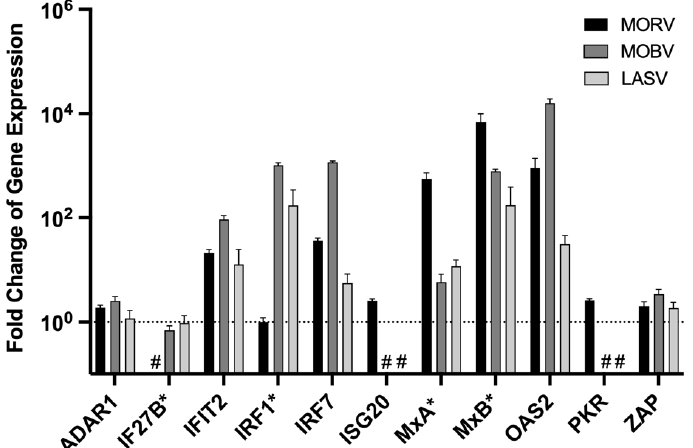
Figure 4. Changes in ISG expression after infection with different arenaviruses. M Φ were infected with either MORV, MOBV, or LASV with an MOI of 1 and incubated for 24 h. RNA was isolated and depleted of DNA. For the RT-PCR-based assays, 10 ng of overall extracted RNA was used. Normalisation was performed with the ΔΔCt method with the housekeeping gene Ppil4. Genes were marked with an asterisk (*) if no signal Ct value for the controls was obtained due to too low concentrations in uninfected cells. The previously determined cut-off Ct values (Table 2) were used to calculate the fold change of ISG expression of these genes. (#) no Ct values were obtained for the experimental and control-treated cells, and a calculation of the fold change of expression was not feasible. The dashed line indicates the normal ISG level of untreated control cells. The experiment was performed in triplicate. Shown are the mean and standard